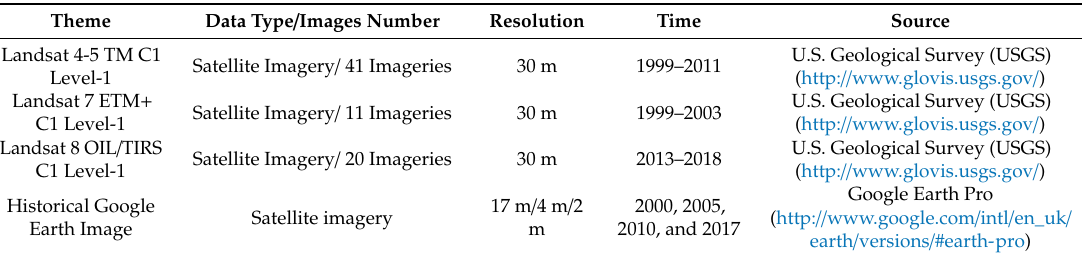
Table 1. Sources of remote sensing